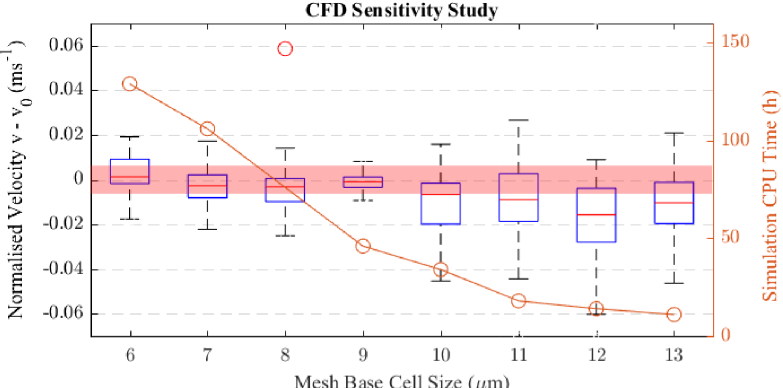
Figure A1. A box-and-whisker plot representation of the CFD sensitivity study results. The whiskers represent the range of the data, the boxes represent the interquartile range, and the lines represent the mean. On the left vertical axis is the velocity magnitude normalised to the co-located point in the simulation with the finest mesh size (5µm). The horizontal is the base mesh size. The right vertical axis is the simulation CPU time in hours. The shaded red region represents the valid region for the mean normalised velocity magnitude.